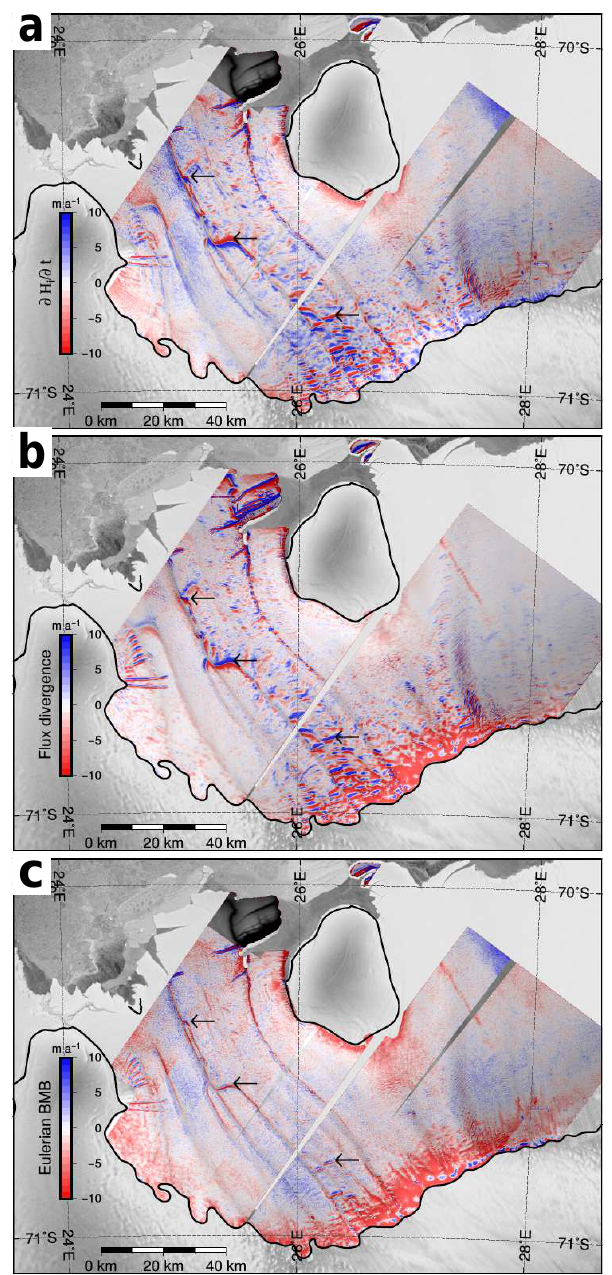
Figure 5. (a) Eulerian thickness change ( ∂H i /∂t ), (b) Flux diver- gence ( ∇ · (H i u ) ) and (c) Eulerian basal mass balance (BMB). Ar- rows point to spurious signal due to advection of ice shelf channels. The background is from the Radarsat mosaic (Jezek and RAMP Product Team, 2002) and the black line delineates the grounding line (Depoorter et al., 2013b).